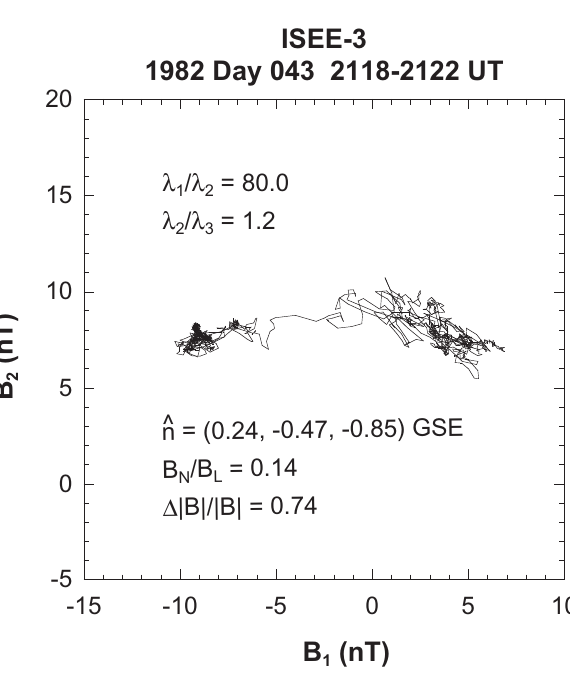
Fig. 8. High-resolution magnetic field data for 12 February 1982. Discontinu- ities are indicated by the dashed vertical lines.